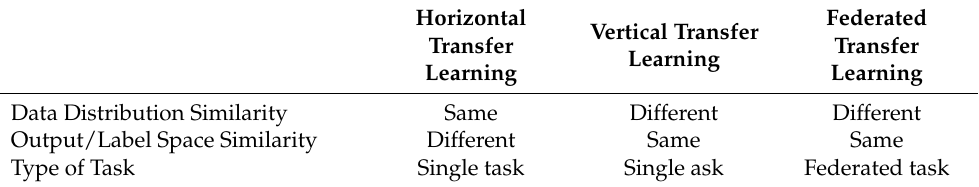
Horizontal Federated Vertical Transfer Transfer Transfer Learning Learning Learning